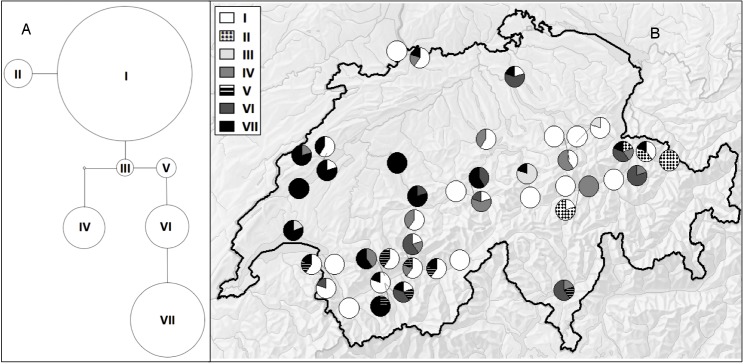
Chloroplast haplotypes.(A) Haplotype network based on statistical parsimony. Circle size corresponds to the number of genotyped individuals with that particular haplotype, while nodes between circles represent the number of changes separating two haplotypes. (B) Distribution of haplotypes across sampled populations in Switzerland. Each pie chart corresponds to one of the sampled populations.